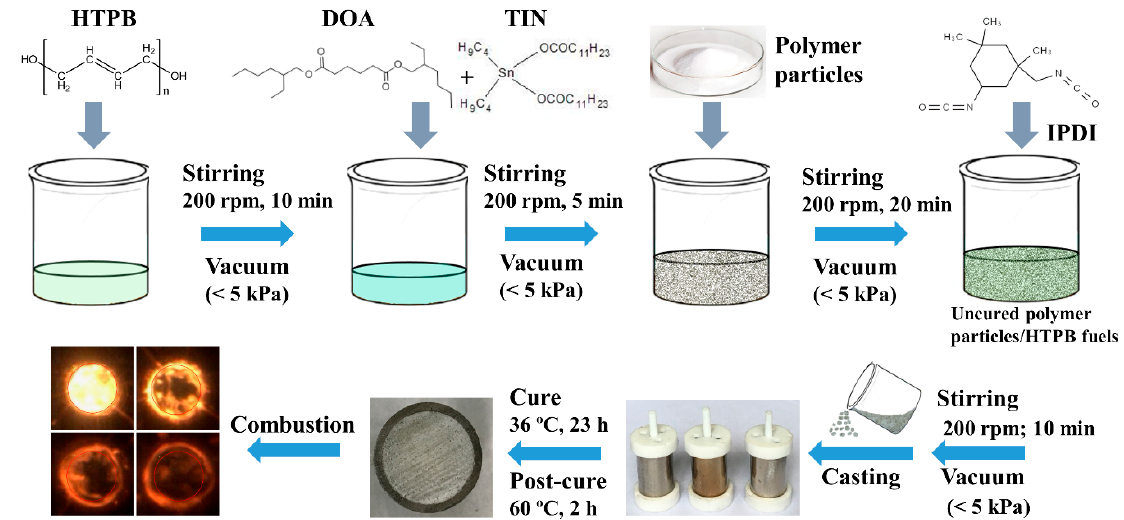
Figure 2. Procedure for the preparation of polymer particles/HTPB (hydroxyl-terminated polybutadiene) composite fuels.